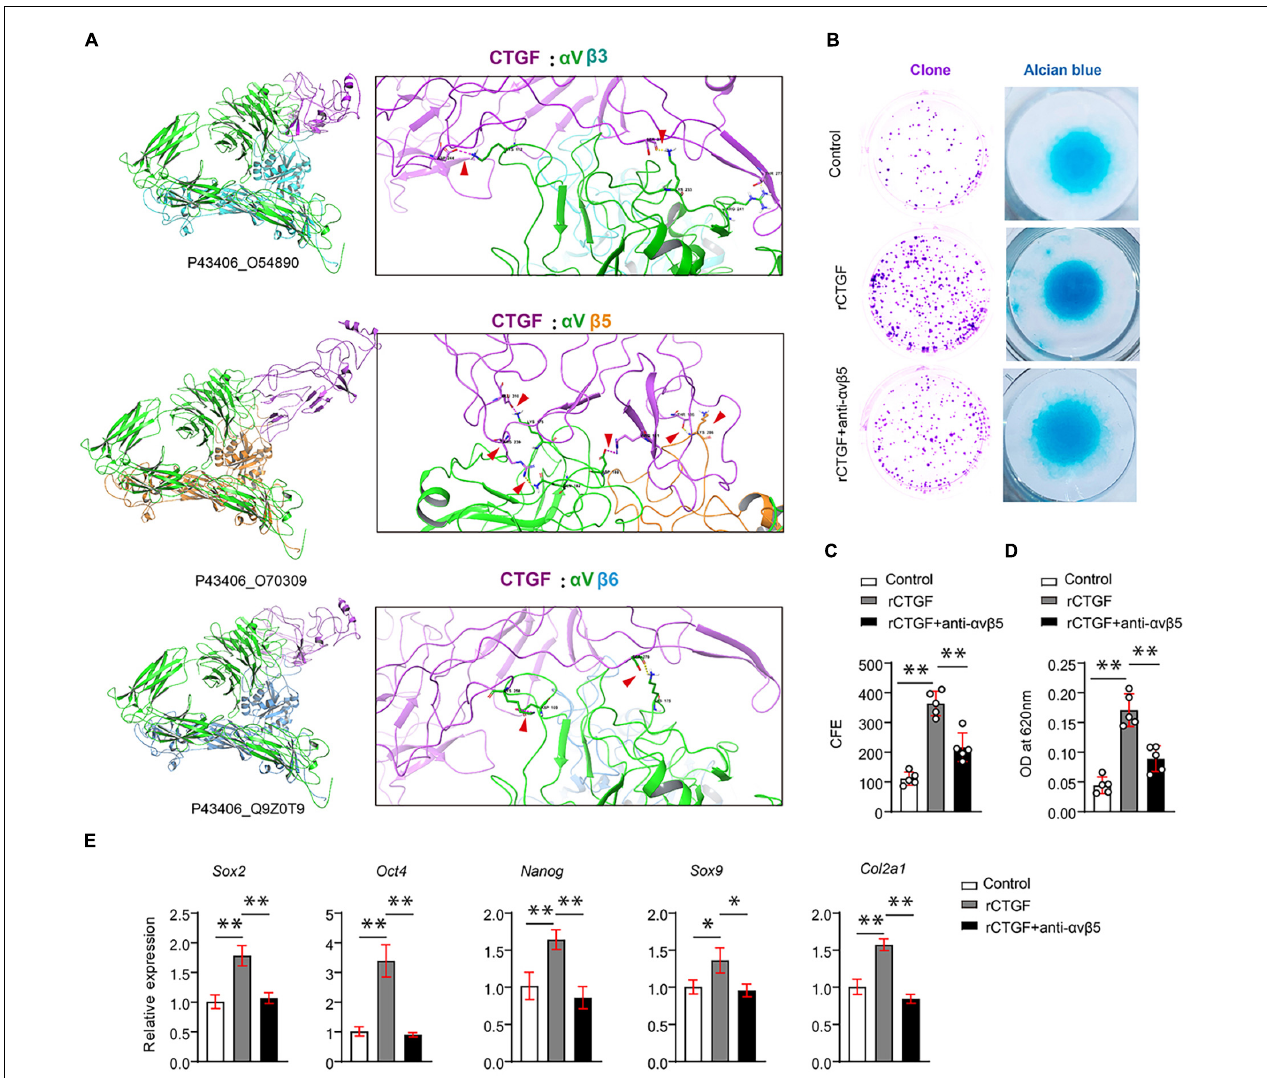
FIGURE 5 | CTGF induces PSCs renewal and chondrogenesis via α V β 5. (A) Results of protein docking showed that the ternary complex structure of α V β 5 (P43406_O70309) and CTGF had the largest binding surface, followed by Q9Z0T9, and O54890 was the worst. (B) Representative images of clone formation efficiency (CFE) and Alcian blue staining. (C) Quantitative analysis of the CFE. (D) Quantitative analysis of Alcian blue staining 620 nm absorbance. (E) Quantitative PCR analysis of Sox2 , Oct4 , Nanog , Sox9 , and Col2a1 after recombinant CTGF (rCTGF) treatment with or without anti- α V β 5 antibody. Data are shown as mean ± SD. ∗ P < 0.05, ∗∗ P <